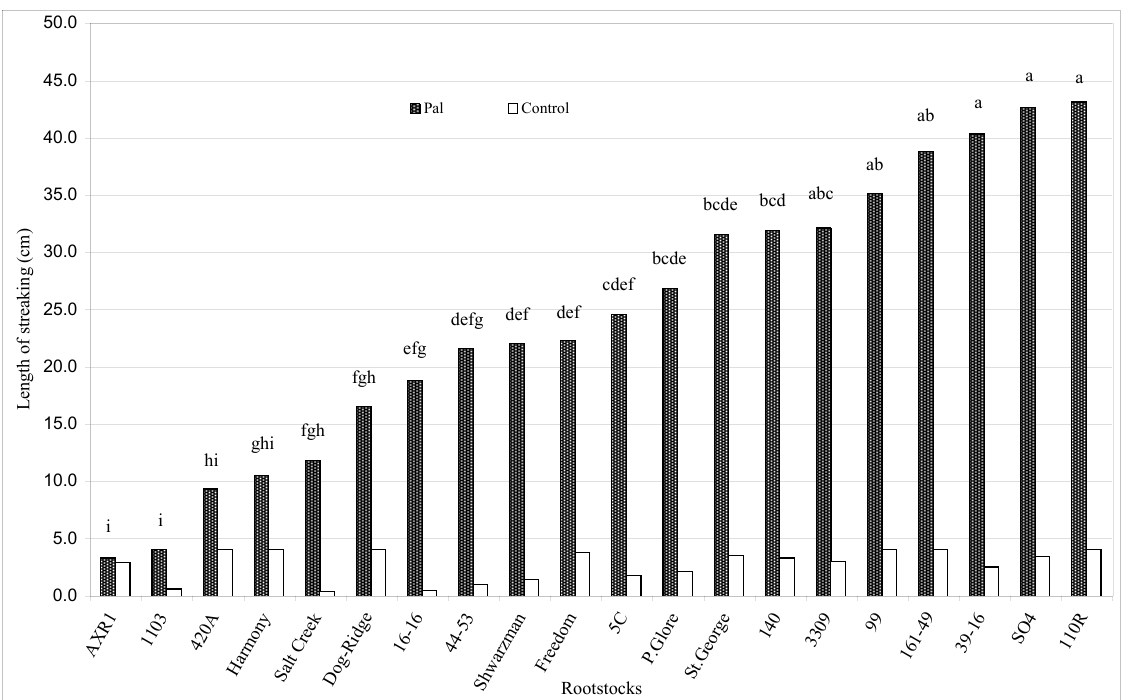
rootstock.Fig. 3. Length of vascular streaking (cm) in Phaeoacremonium inflatipes (Pin) inoculated